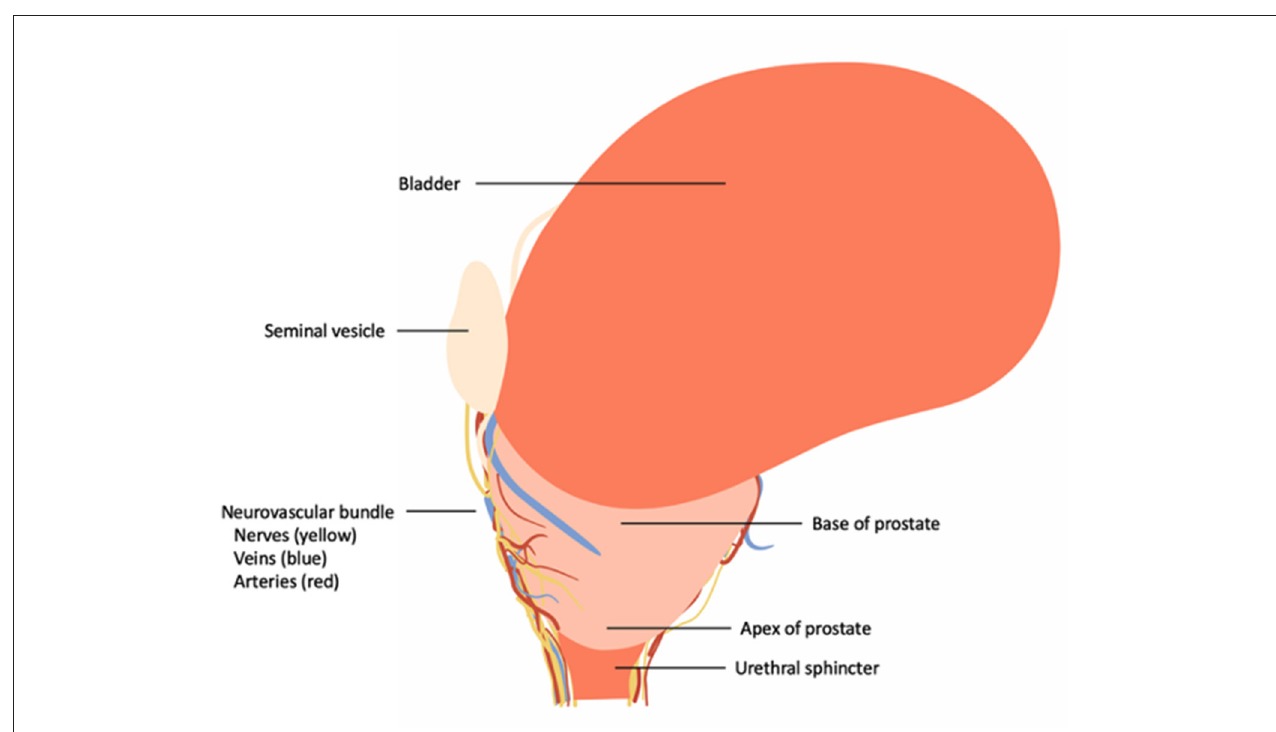
FIGURE 1 | Overview of the topographic location of the prostate and its correlation to the urinary bladder, neurovascular bundle and urinary sphincter